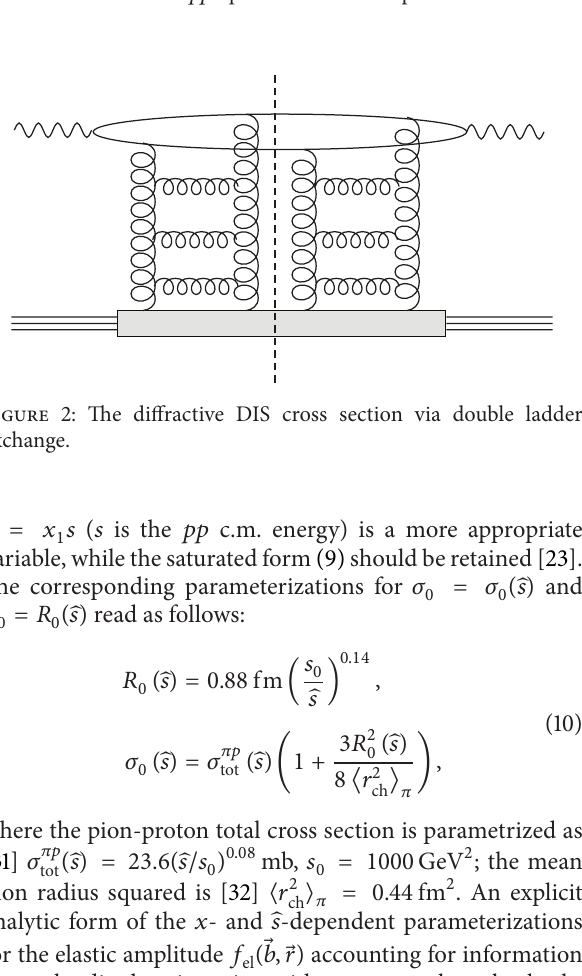
Figure 1: The DIS cross section via phenomenological Pomeron exchange (a) and a perturbative QCD ladder (b). At small 𝑥 the virtual photon fluctuates into 𝑞𝑞 dipole and more complicated Fock states which then interact with the hadronic target.